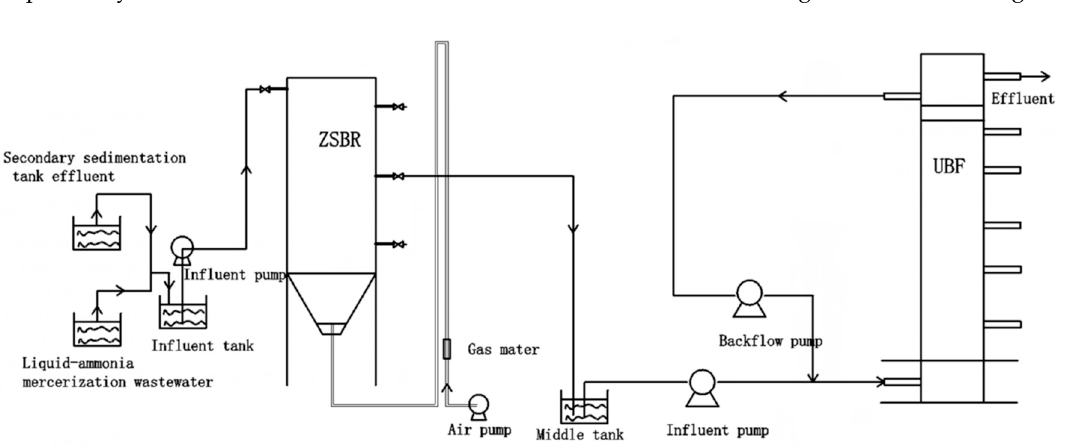
Figure 1. Schematic diagram of a zeolite sequencing batch reactor (ZSBR) combined with an up-flow blanket filter (UBF) as a partial nitritation / anammox (PN / A) process for liquid-ammonia mercerization wastewater.